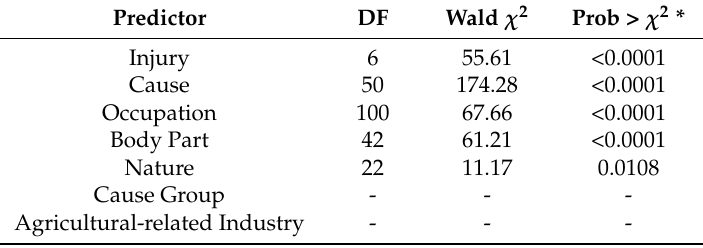
Table 7. Effect test results for the GLM with lognormal distribution using the lasso penalization method.